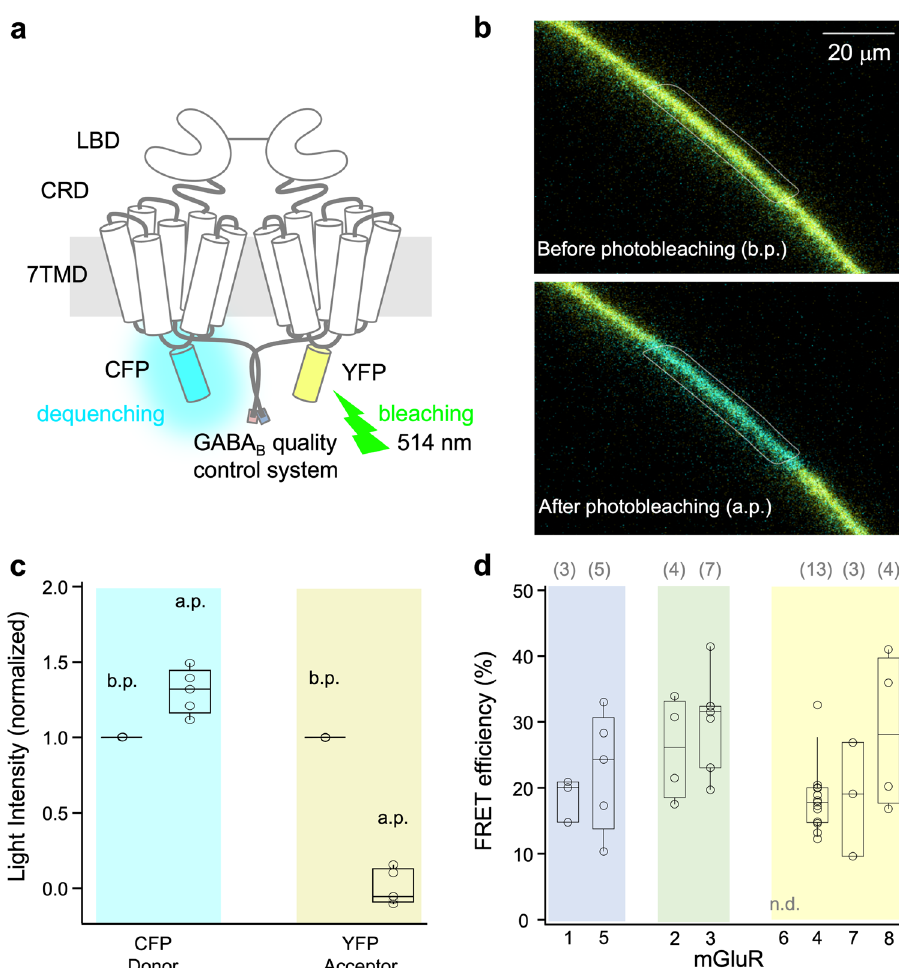
Fig. 1 Donor dequenching after photobleaching the acceptor in homodimeric mGluRs. a Cartoon of a dimeric mGluR. Each subunit contains an N-terminal ligand-binding domain (LBD) that is connected to a cysteine-rich domain (CRD) which is connected to a seven-helix transmembrane domain (7TMD). The cyan or yellow fl uorescent protein, CFP, and YFP are included in the intracellular i2 loop. The quality control system of the GABA B receptor was used to control the composition of the receptors to be analyzed (see Methods). The principle of acceptor-bleaching induced donor dequenching is indicated. b Confocal micrograph of an oocyte membrane expressing mGluR2/7 before (top) and after photobleaching with the light of 514 nm (bottom). The membrane region with the bleached yellow signal is easily visible. c FRET ef fi ciency for the representative example mGluR5 for donor dequenching by photobleaching of the acceptor. b.p., and a.p. means before and after photobleaching, respectively. The light intensity of the donor was increased by 23 ± 4%. d FRET ef fi ciency of the donor was evoked by photobleaching the acceptor for the eight homodimeric mGluRs. The values were obtained from 3 to 7 cells. n.d., not determinable. The numbers of experiments are shown at the top in